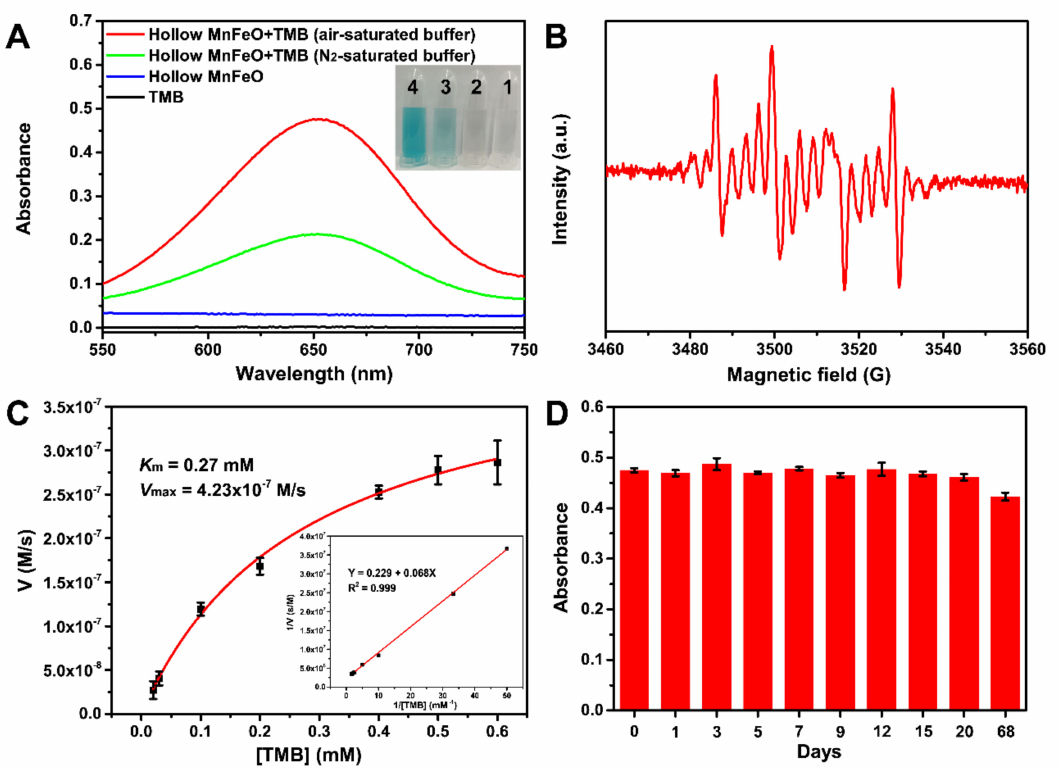
Figure 2. ( A ) compares UV-vis spectra of different systems, and the inset is the corresponding photograph (1—TMB; 2—Hollow MnFeO; 3—Hollow MnFeO+TMB in N 2 -saturated buffer; 4—Hollow MnFeO+TMB in air-saturated buffer). ( B ) shows the EPR spectrum of the hollow MnFeO solution with 5,5-dimethyl-1-pyrroline-1-oxide as a capturer. ( C ) records kinetic plots of hollow MnFeO catalyzing the TMB chromogenic reaction, and the inset shows the corresponding dou- ble reciprocal graph. ( D ) demonstrates the excellent stability of hollow MnFeO as an oxidase mimic stored in DW at room